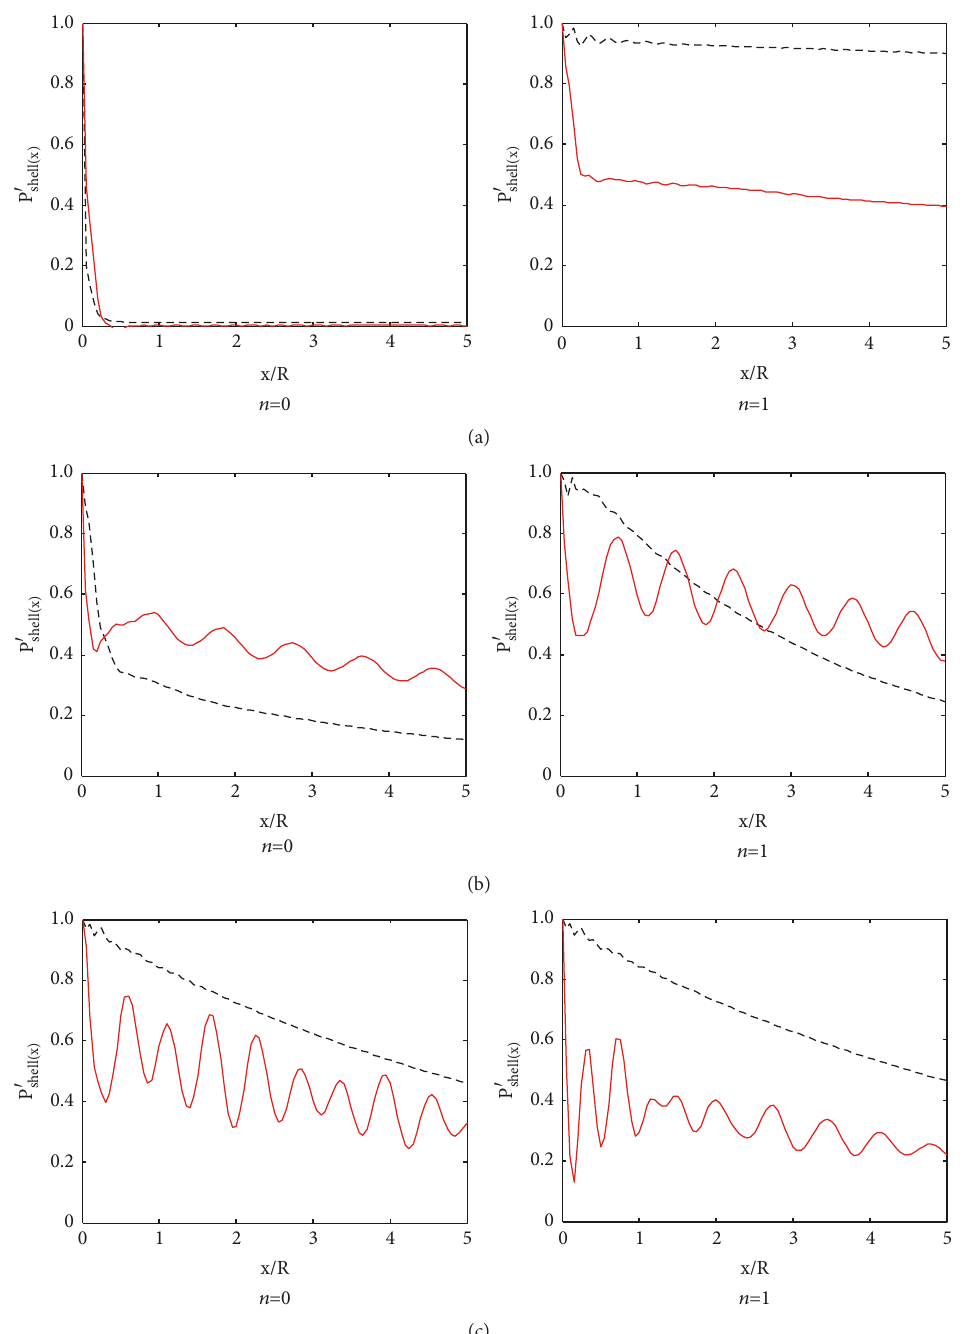
Figure 4: Power transmitted by the shell filled and unfilled with water: (a) Ω = 0.3 , (b) Ω = 1.2 , and (c) Ω = 3.0 ; black dashed line: in vacuo; red solid line: